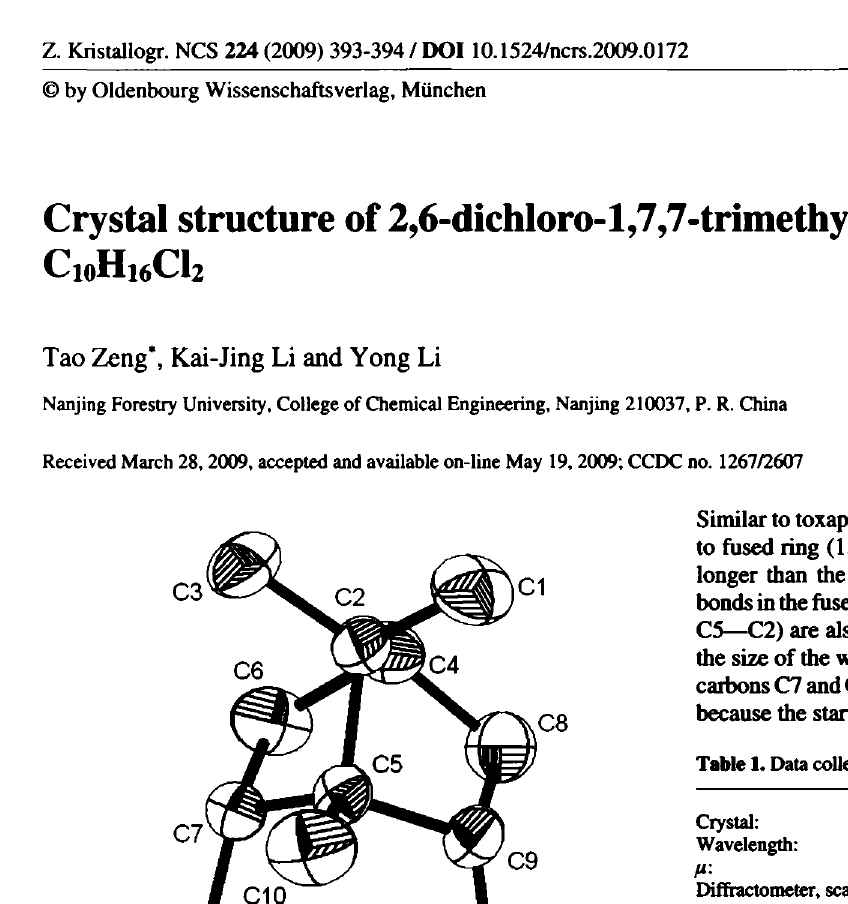
Table 1. Data collection and handling.